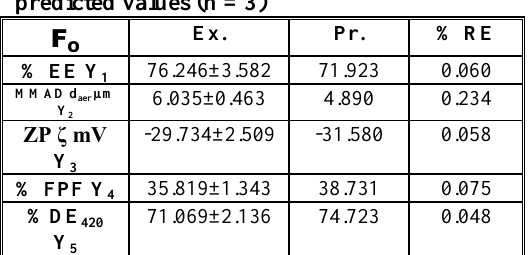
Table 9: Optimized formula experiemntal / predicted values (n = 3)